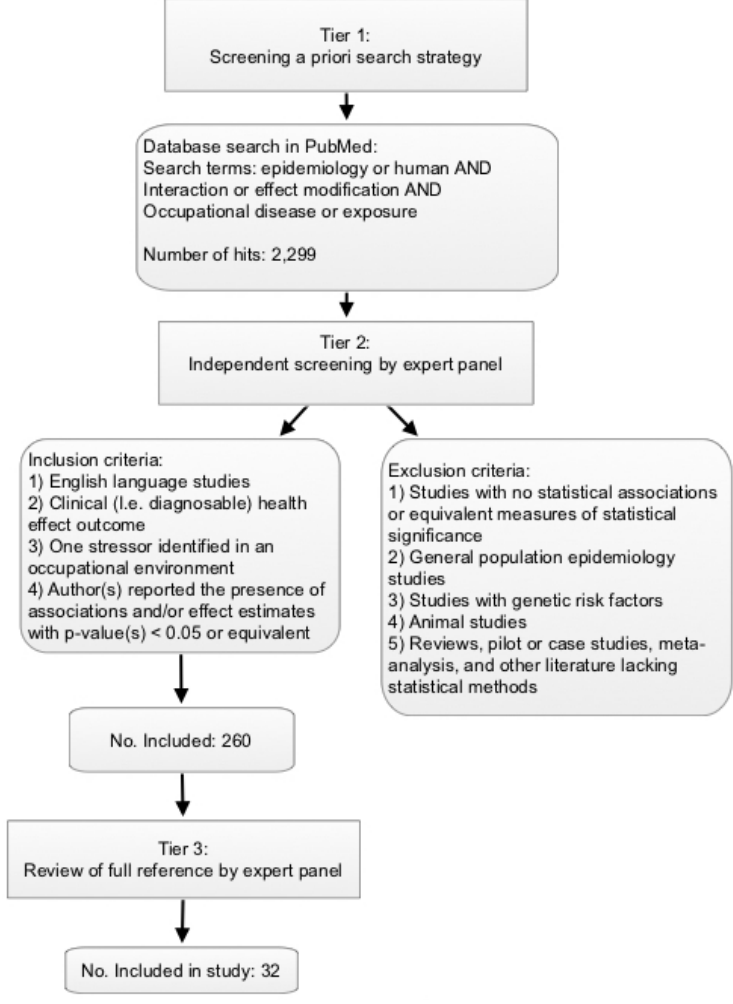
Figure 1. Scoping review schematic.